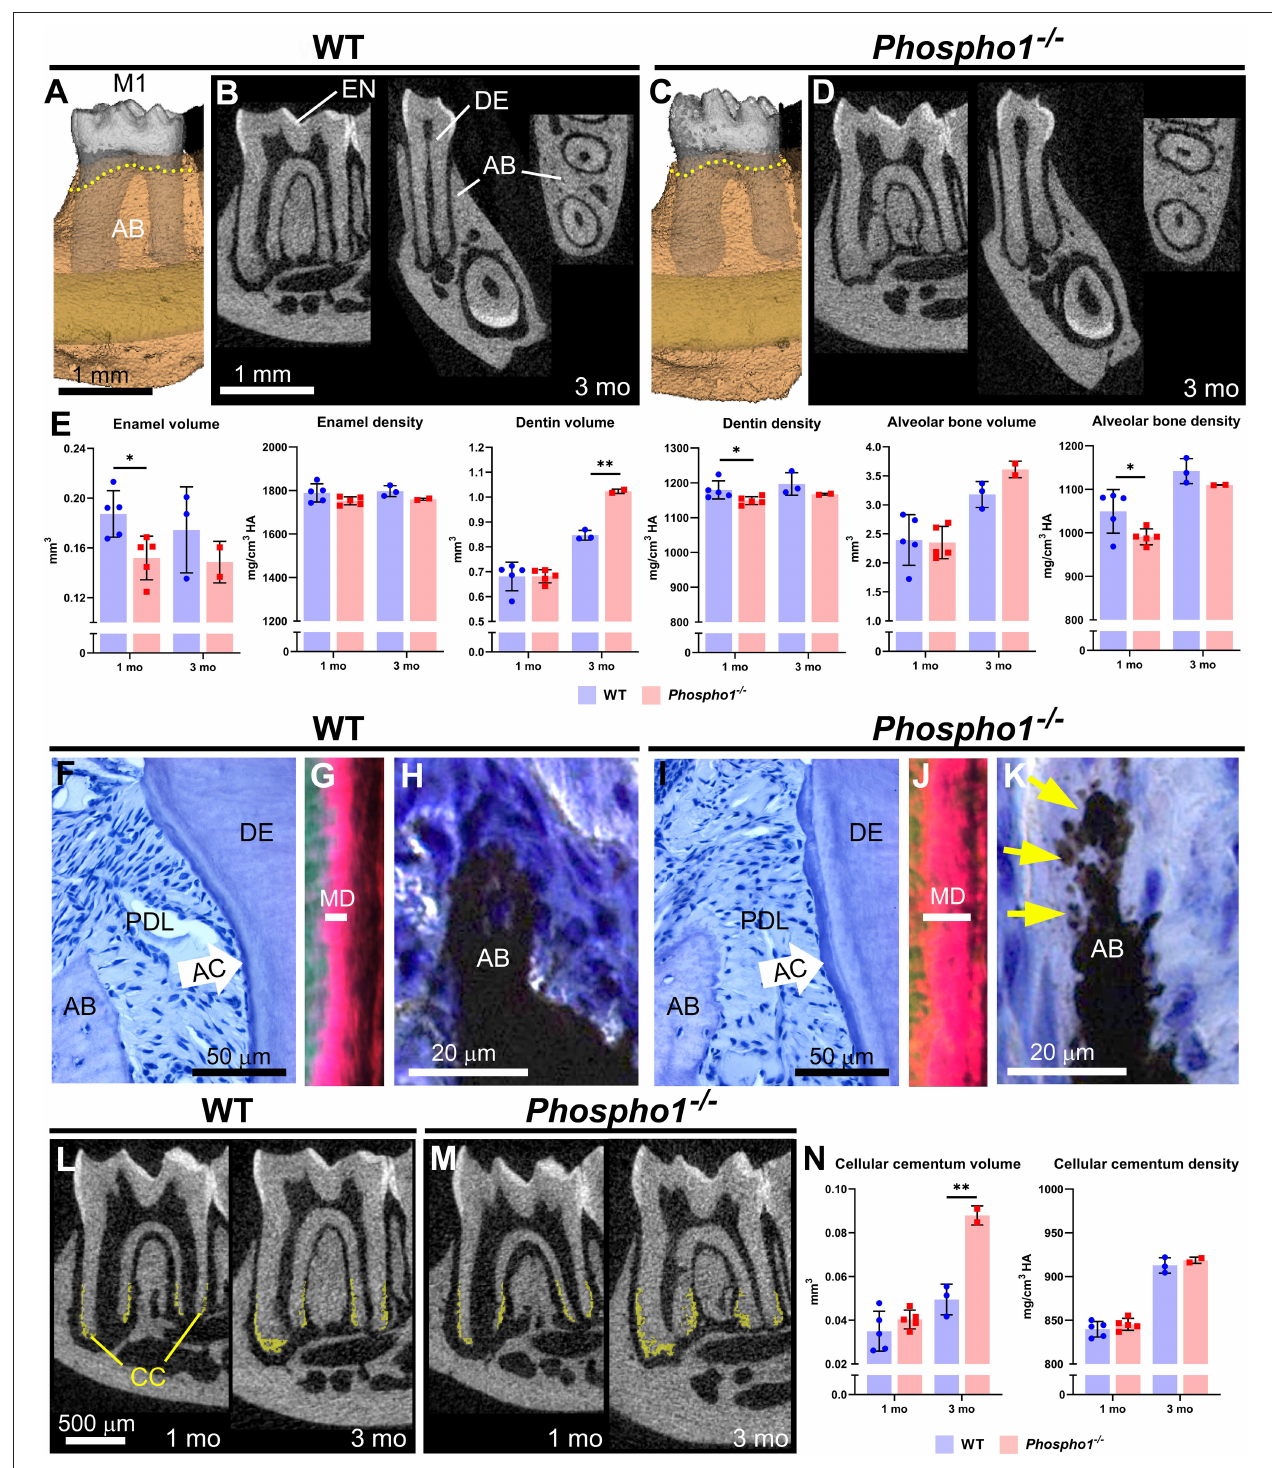
FIGURE 2 | Dentoalveolar defects in Phospho1 − / − mice. (A–D) 3D and 2D renderings of first molars (M1) from WT and Phospho1 − / − mice at 3 months (mo), including enamel (EN), dentin (DE), and alveolar bone (AB). AB levels (yellow dotted lines in A and C) are similar in Phospho1 − / − vs. WT mice at 3 mo. (E) Compared to wild-type (WT), Phospho1 − / − mice have mild enamel hypoplasia and reduced DE and AB mineral densities at 3 mo. (F, I) H&E stain of WT and Phospho1 − / − dentoalveolar tissues at 3 mo showing intact acellular cementum (AC) layer and periodontal ligament (PDL) attachment. (G, J) Picrosirius red stain viewed under polarized light shows abnormally expanded mantle dentin (MD) layer (note length of the white bar) in Phospho1 − / − vs. WT mice, where DE mineralization defects are